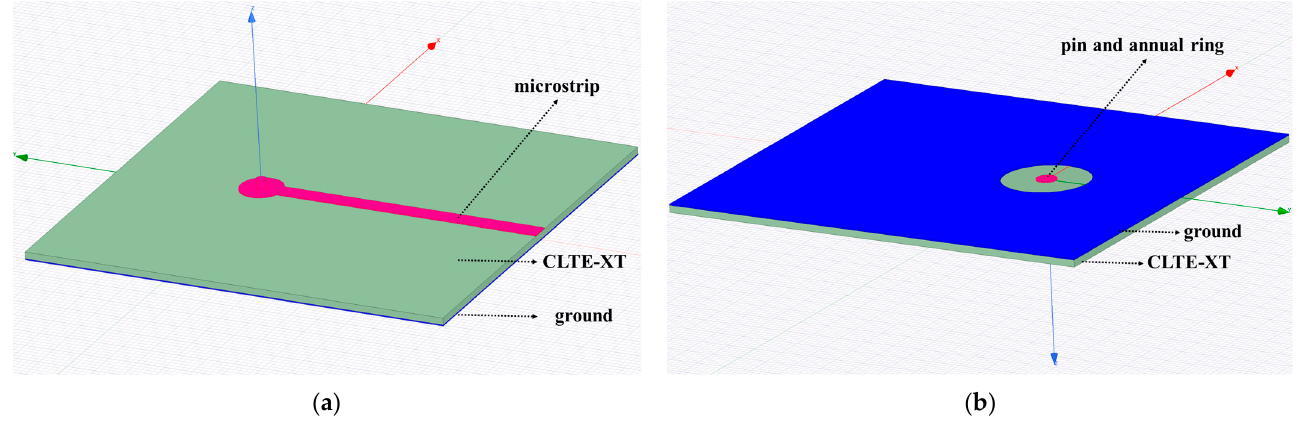
Figure 4. SMP-to-microstrip vertical transition model: ( a ) front side of the simulation model; ( b ) back side of the simulation model.